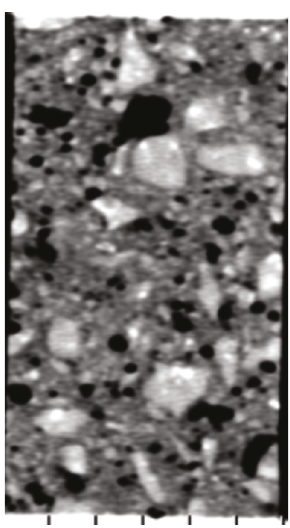
Figure 8: Initial graph of the CT section.